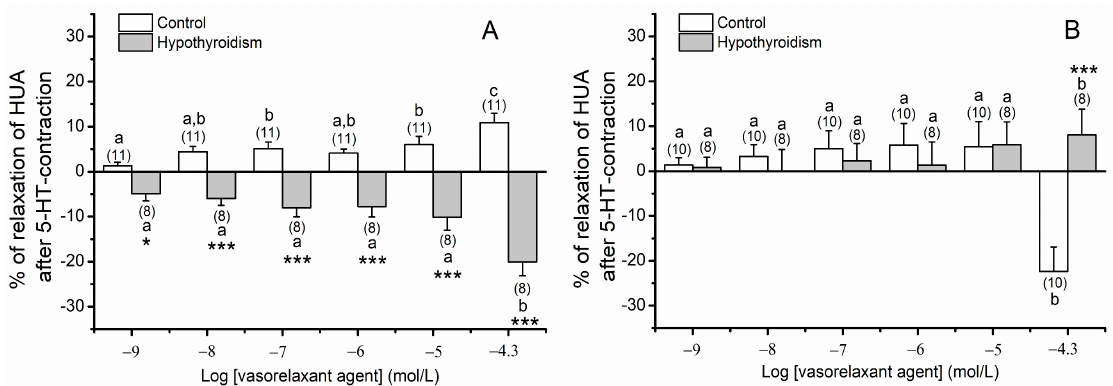
Figure 3. Percentage of relaxation of human umbilical artery (HUA) rings without (control) and with hypothyroidism incubated with ( A ) 0 µmol/L and ( B ) 50 µmol/L of octylmethoxycinnamate (OMC) and contracted by serotonin (5-HT; 1 µmol/L). Each bar represents the mean, vertical lines the S.E.M. and the number within brackets the n . Asterisk * represents a significant difference versus hypothyroidism: * p < 0.05 and *** p < 0.001, and the different letters represents significant differences between OMC concentrations ( p < 0.05); two-way ANOVA method followed by Holm–Sidak post-hoc tests.